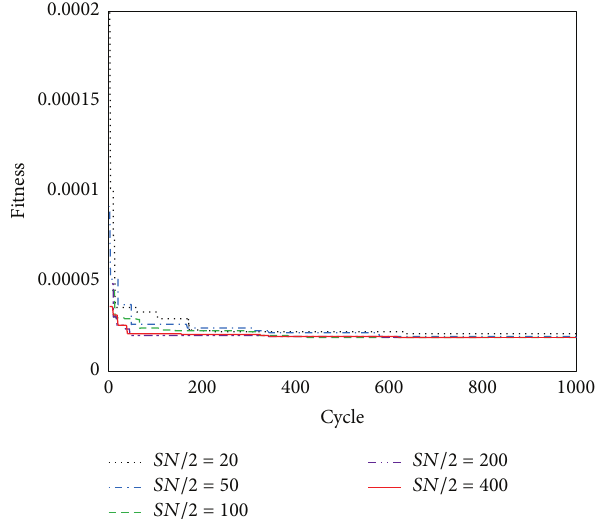
Figure 9: The convergence of different population size.